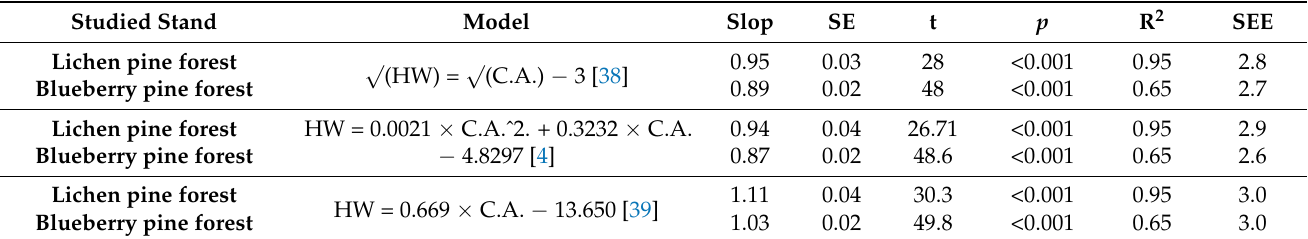
Table 6. Models developed for pine trees [4,38,39] describe the number of heartwood rings as a function of cambium age for Scots pine and general statistics for lichen and blueberry pine forests.